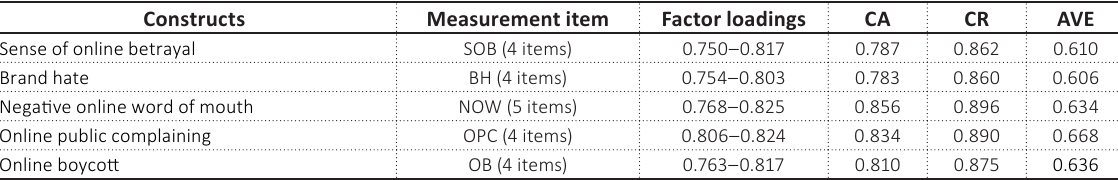
Table 1. Internal consistency reliability and convergent validity